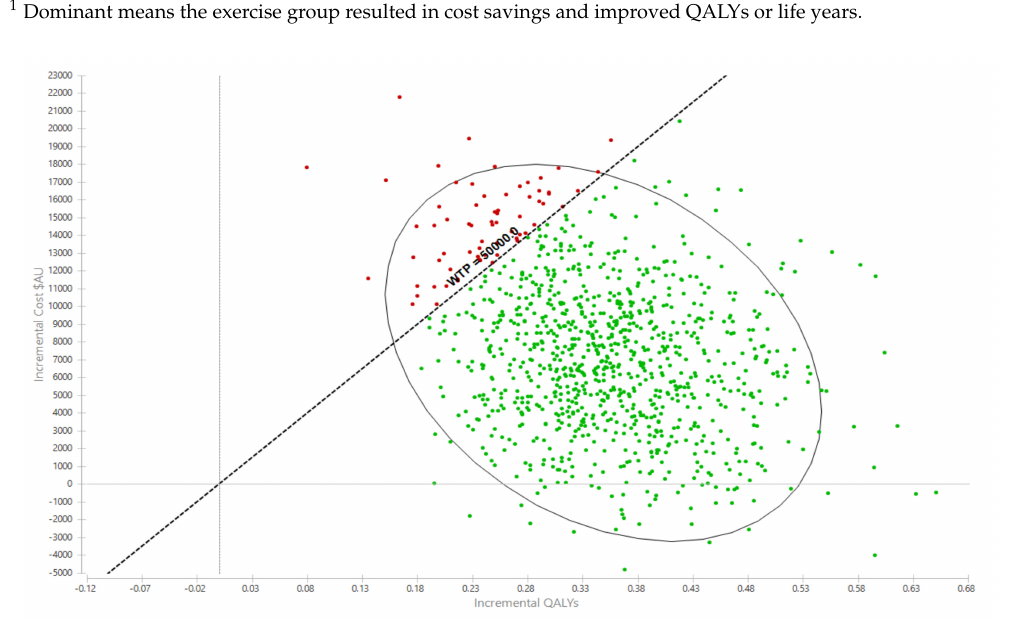
Figure 2. Probabilistic sensitivity analyses, incremental cost per QALY gain scatterplot. AU$ = Australian dollars, QALY = quality-adjusted life